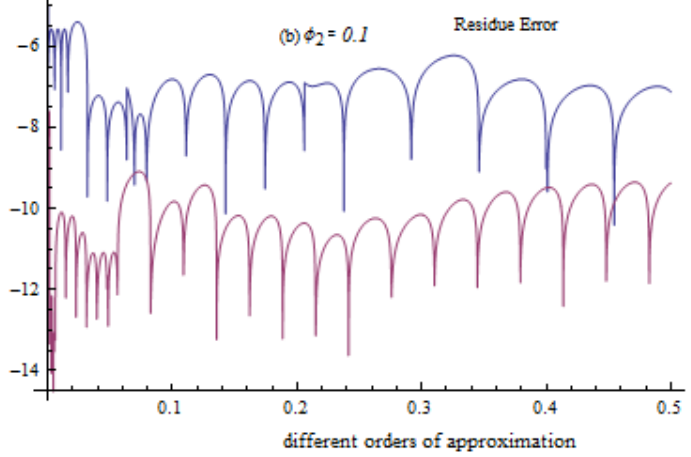
Figure 7. Error ( a ) and residue error ( b ) for 𝜙 2 = 0.1. The blue line represents the average residue error and the red line represent the total average residue error in ( b ).